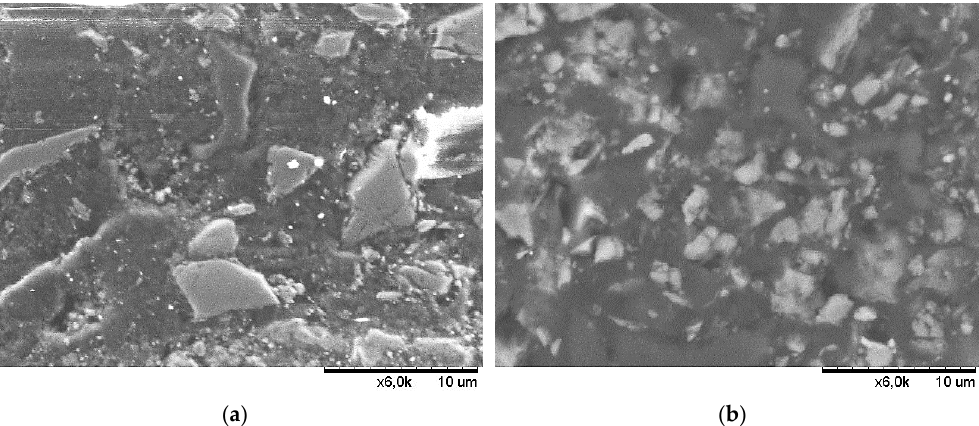
Figure 8. SEM micrographs (magnification: 6000×) of vinyl-ester composites with various contents of fly ash FA F : ( a ) composite with 21% content of fly ash in the microfiller (ID: No. 3 acc. to Figure 5); ( b ) composite with 79% content of fly ash in microfiller (ID: Np. 7 acc. to Figure 5)